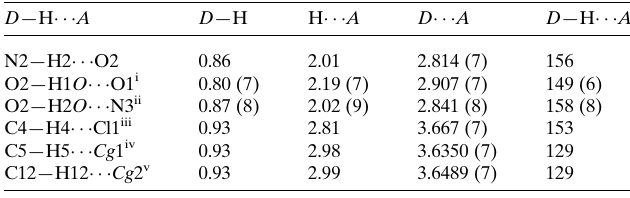
Figure 1 The molecular structure of the title compound with displacement ellipsoids drawn at the 40% probability level. H atoms are shown as small spheres of arbitrary